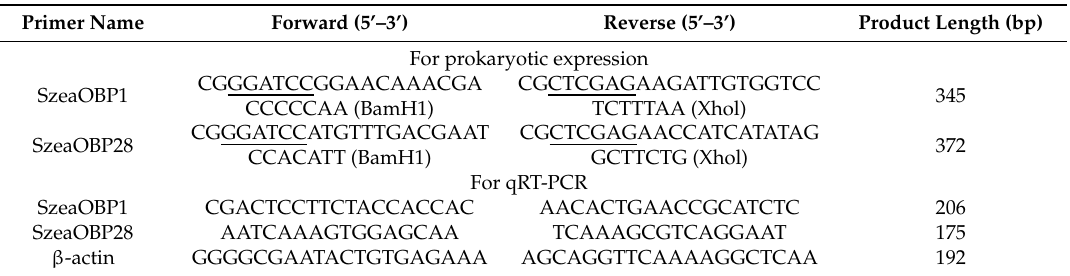
Table 2. Primers used in this